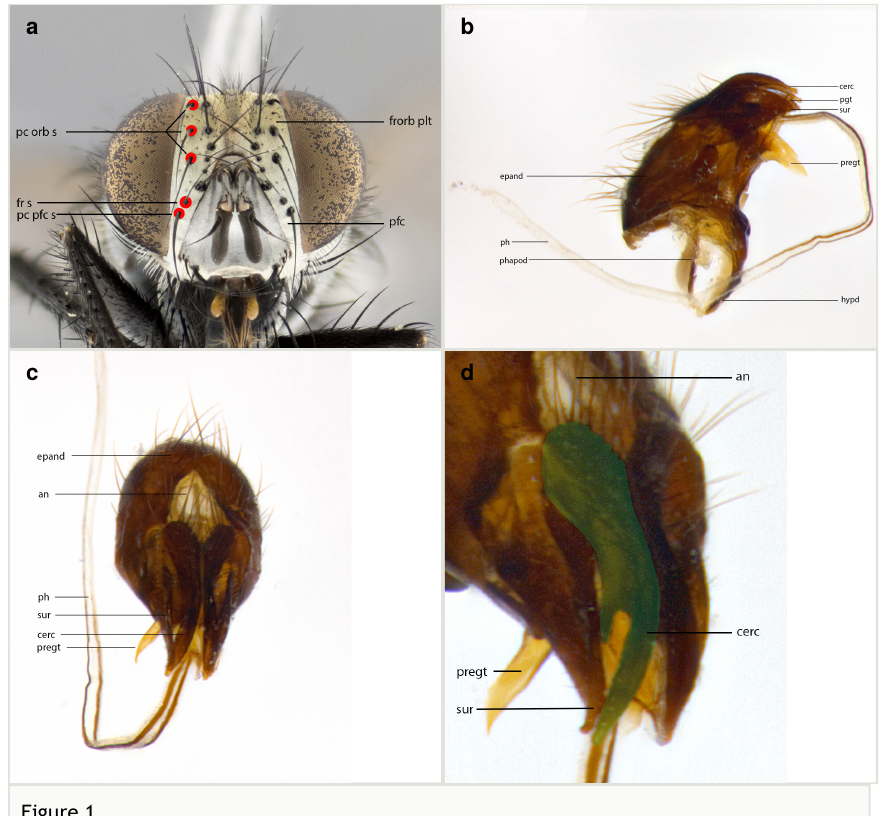
Salient features of Voria erasmocoronadoi sp. n. ; a : female paratype n. DHJPAR0006953; c– d: male paratype n.